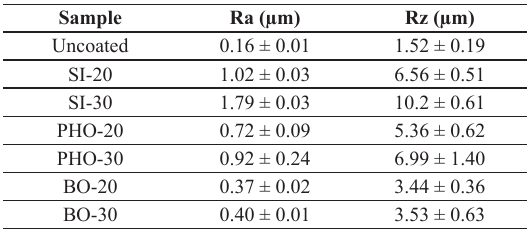
Table 3. Roughness parameters of the as-received and anodized